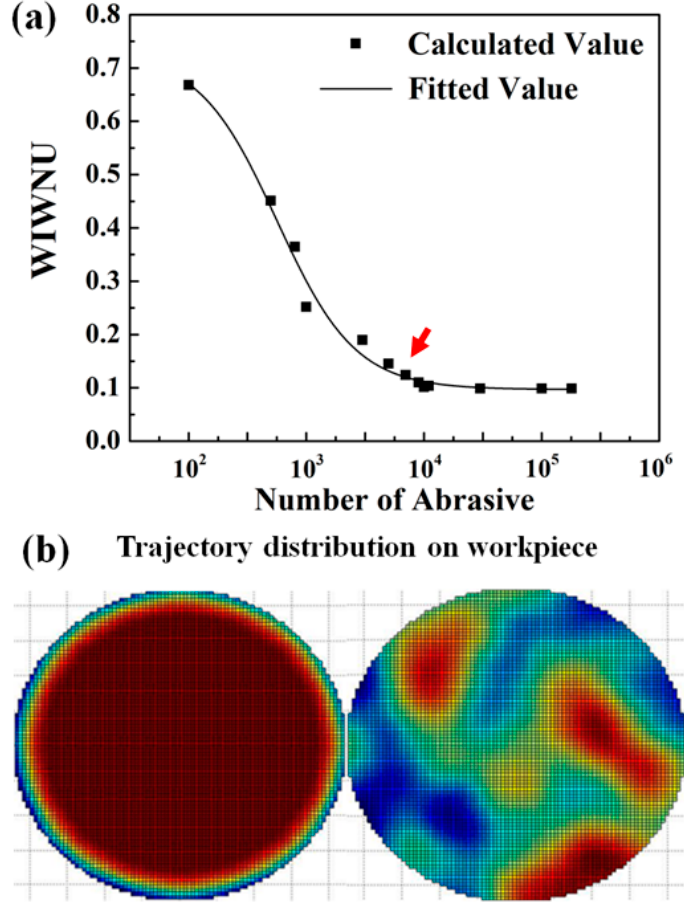
Figure 2. ( a ) Plot of the non-uniformity coefficient of trajectory against the number of lapping grits; ( b ) trajectory distribution on a workpiece lapped by plates with evenly (left) and randomly (right) distributed grits.